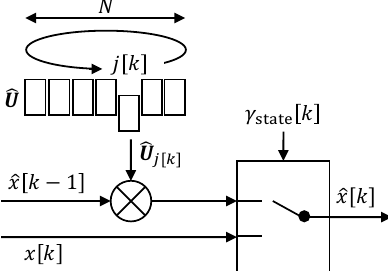
Figure 5. Flow chart of the trajectory-based event-triggered state estimation (ETSE). The model is a trajectory ˆ U of rotations (represented by quaternion increments) of one cycle with length ˆ N . At every sampling instant, we multiply the previous orientation estimate ˆ x [ k − 1 ] with the rotation at index j [ k ] to obtain the prediction for sampling instant k . If the state-update trigger γ state [ k ] is zero, then we employ this prediction as orientation estimate ˆ x [ k ] ; otherwise, we use the measurement x [ k ]